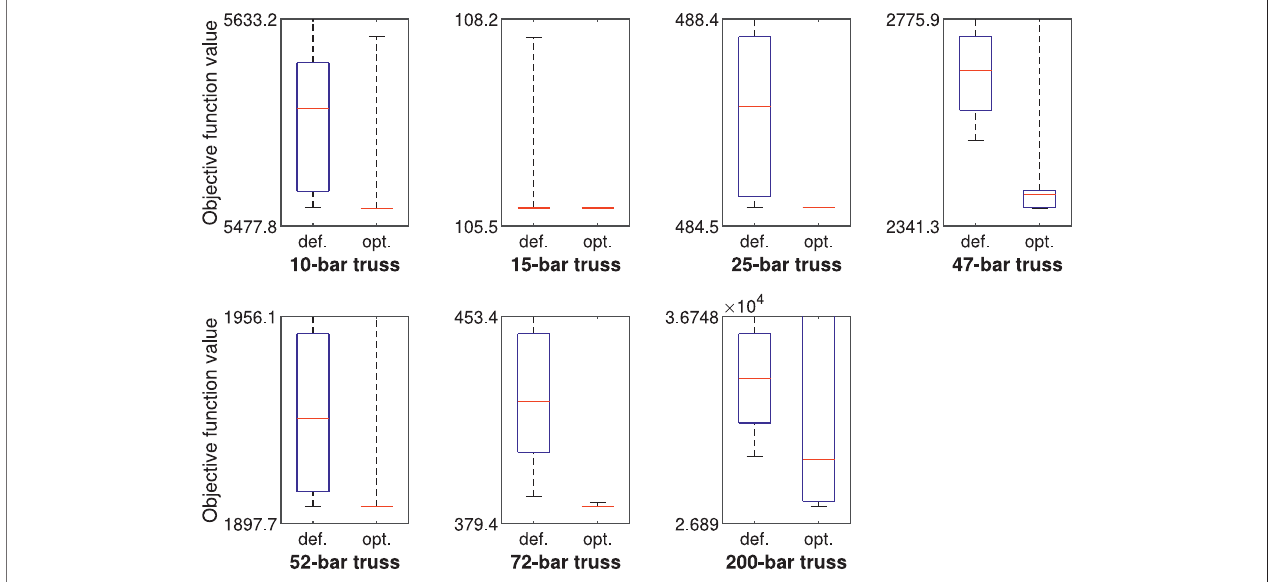
FIGURE 9 | Summary of results of the GA when applied to the truss test problems, with default (def.) and optimized (opt.) control parameter values. The system (bottom whisker, box bottom, middle, top, top whisker) denotes the (minimum, 10-th percentile, median, 90-th percentile, maximum) objective function value in 100 independent runs of the